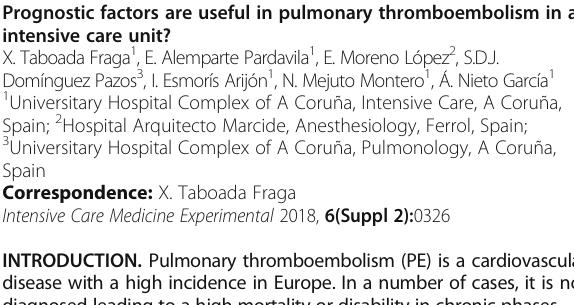
Table 2 (abstract 0326). Symptoms and diagnostic test